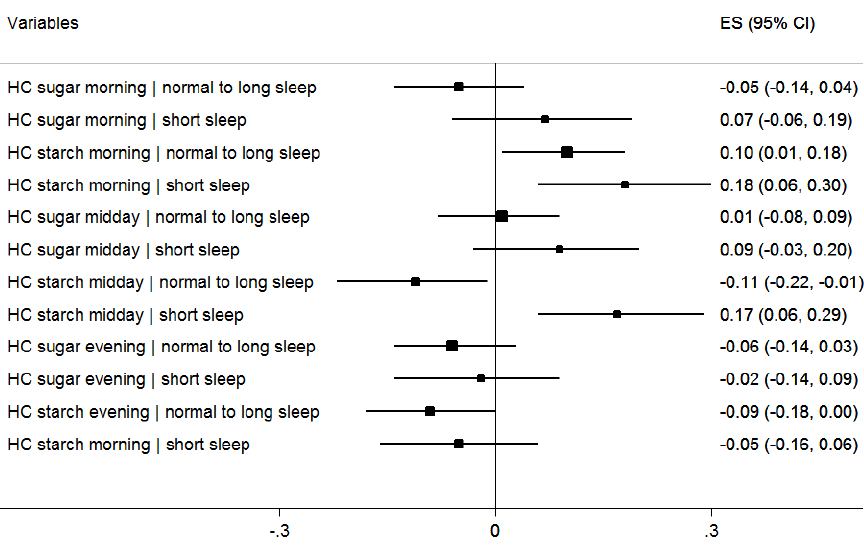
Figure 3. Effect of HC intake (sugar and starch) at 3 meal occasions on BMI z-scores at baseline by sleep duration. ES = effect size (regression coefficient). n reduced from 5944 at baseline due to non-response on two variables: breakfast and parental education level ( n = 5750); Linear regression of BMI z-scores on sleep duration, HC intake variables, and their respective product terms, further adjusted for eating breakfast, parental education, age, sex, and survey country. Long sleep represents normal and long sleep ≥ 10 hours. CI: Confidence Interval.